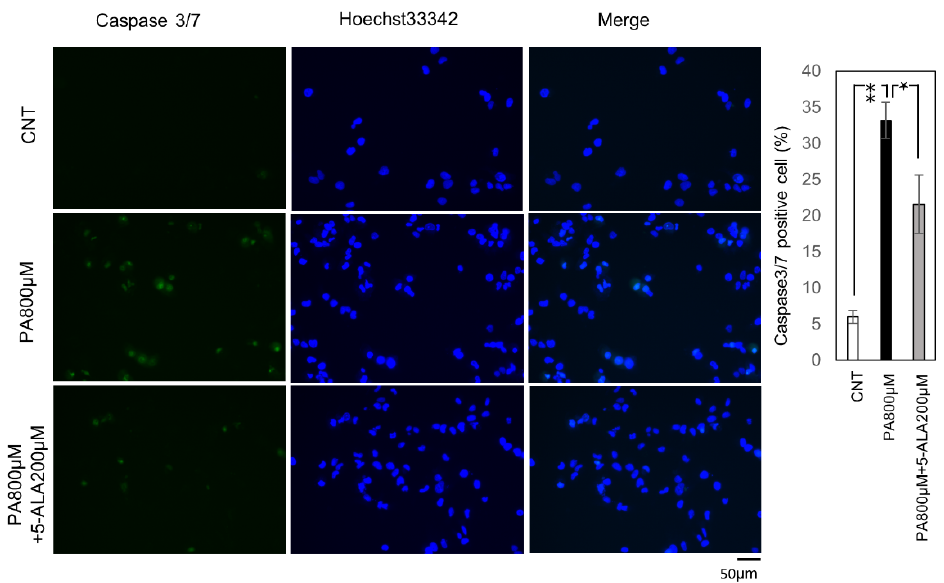
Figure 3. Fluorescein active Caspase-3/7 staining. Huh-7 cells treated with 1% BSA were the controls, and palmitic acid 800 μ M with or without 5-ALA 200 μ M the treatment groups. The results were expressed as the ratio compared with the control. The quantification is based on ten randomly captured fields in each group. Bars indicate average ± SEM. * p < 0.05, ** p < 0.01. CNT, control; PA, palmitic acid.